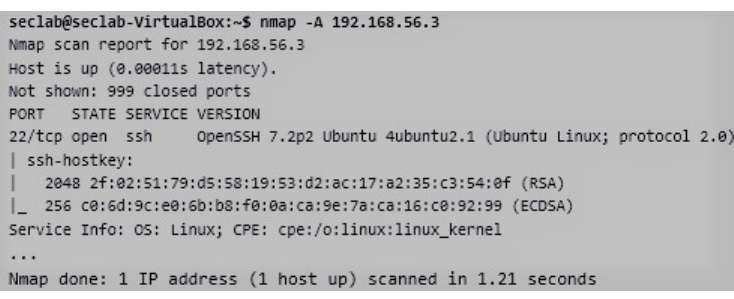
Figure 5. Discovering of Open Ports and Services for a set of Network Device.